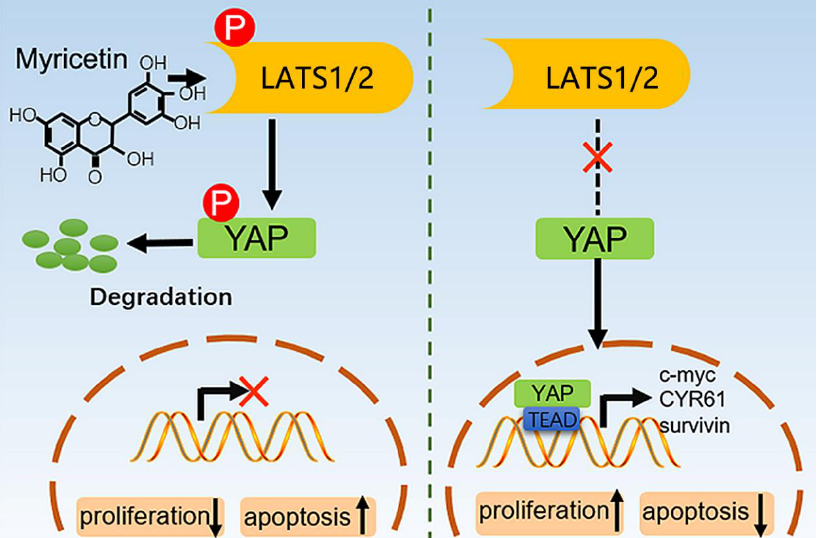
Figure 7. The model for myricetin regulating YAP expression. Myricetin stimulates phosphorylation and activation of LATS1/2 kinases, which in turn directly phosphorylate YAP on serine residues, leading to proteasomal degradation. Therefore, the transcription of the downstream effectors of YAP, such as CTGF, c-myc, CYR61 and survivin, are blocked.